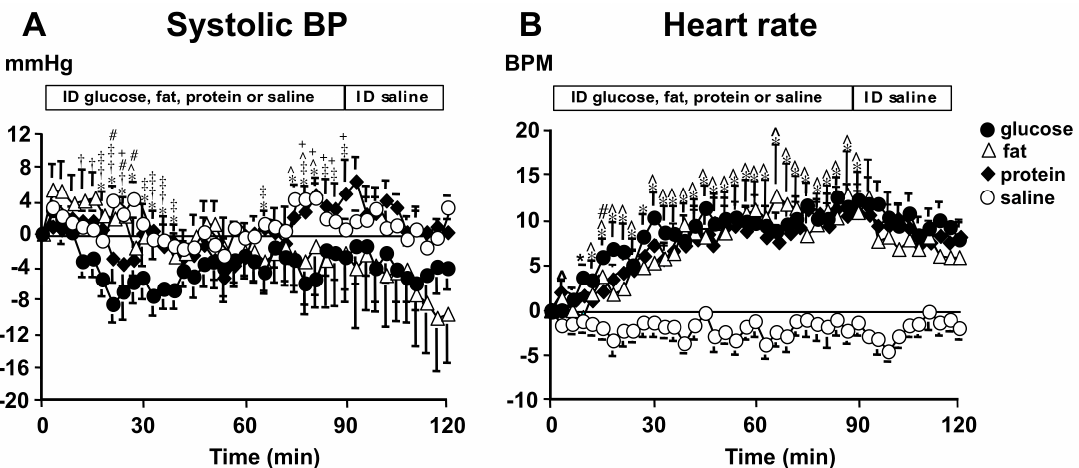
Figure 1. Changes from baseline in ( A ) Systolic blood pressure (BP) and ( B ) Heart rate in eight healthy older participants in response to intraduodenal (ID) infusion of glucose, fat, protein, and saline. Values are means ± SEM. * p < 0.05 for glucose compared with saline; † p < 0.05 for glucose compared with fat; ‡ p < 0.0001 for glucose compared with protein; ^ p < 0.05 for fat compared with saline; # p < 0.05 for protein compared with saline; + p < 0.05 for fat compared with protein [14]. BPM = beats per minute.